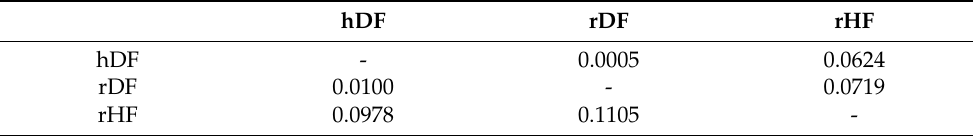
Table 2. Estimated pairwise Fst (fixation index) as a measure of genetic differentiation between the three groups (Weir and Cockerham mean Fst, above diagonal; Weir and Cockerham weighted Fst, below diagonal; hDF, historic Dutch Friesian; rDF, recent Dutch Friesian; rHF, recent Holstein Friesian).